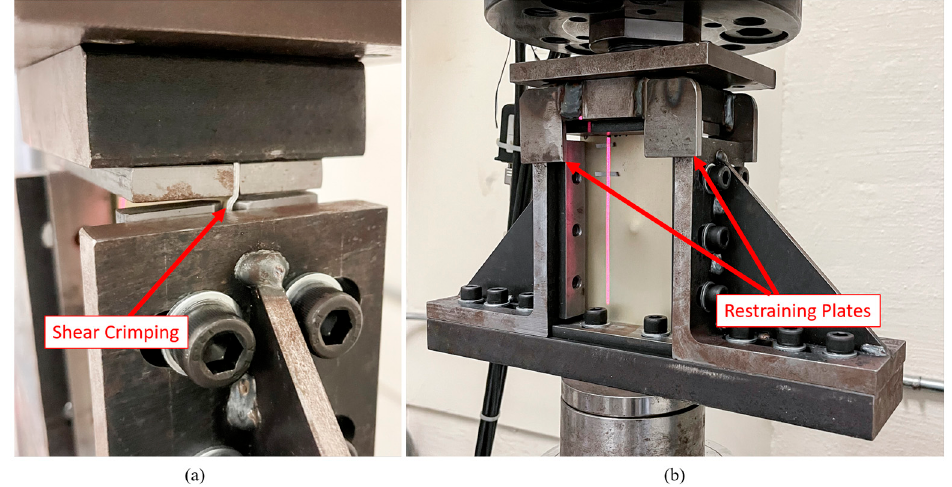
Figure 14. CAI fixture: ( a ) shear crimping of thinner specimens when using the standard. CAI fixture: ( b ) the modi fi ed fi xture.